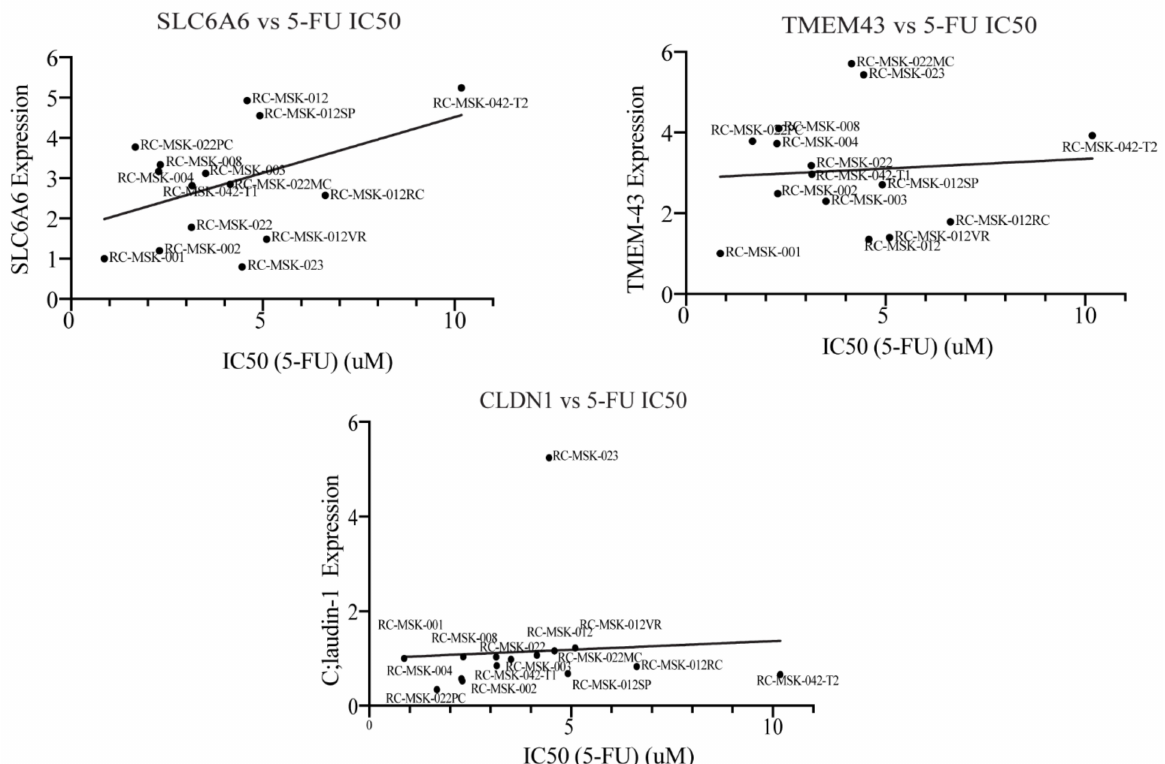
Figure 8. Metastatic rectal and colon tumoroids display elevated expression of Claudin-associated molecular signature proteins with increased tolerance to 5-FU. ( A ) Western blot analysis demonstrates expression of PIK3CA, SLC6A6, TMEM-43, ASAP-1, CLDN1 in the patient-derived tumoroids. PR, perineal recurrence; SP, splenic metastasis; RC, rectal recurrence; VR, vaginal recurrence; MC, mid-chemo; PC, post-chemo; T1 and T2 were sampled from different parts of the same tumor. ( B ) The Pearson’s correlation between the expression of protein and IC50 values displayed by tumoroids is displayed in the box